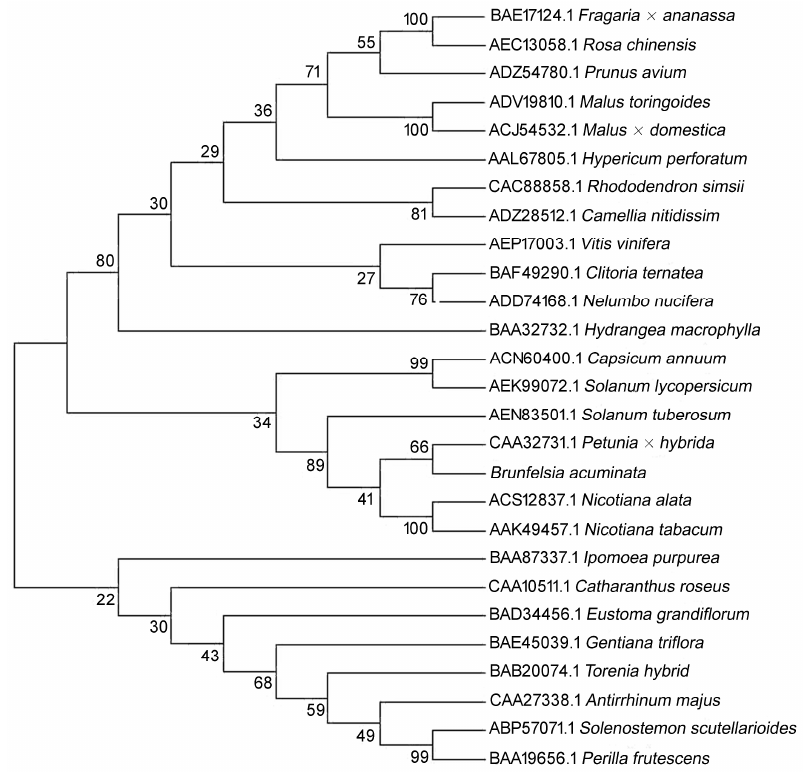
Figure 5. A Phylogenetic tree of deduced amino acid sequences of CHS constructed by software ClustalX 1.8 and MEGA 5.0 from Brunfelsia acuminata and from various other plant species. The phylogenetic tree is a neighbor-joining tree calculated by Poisson model, and the bootstrap values are from 1000 replications. The plants’ names and their Genbank accession numbers are all shown in the figure.